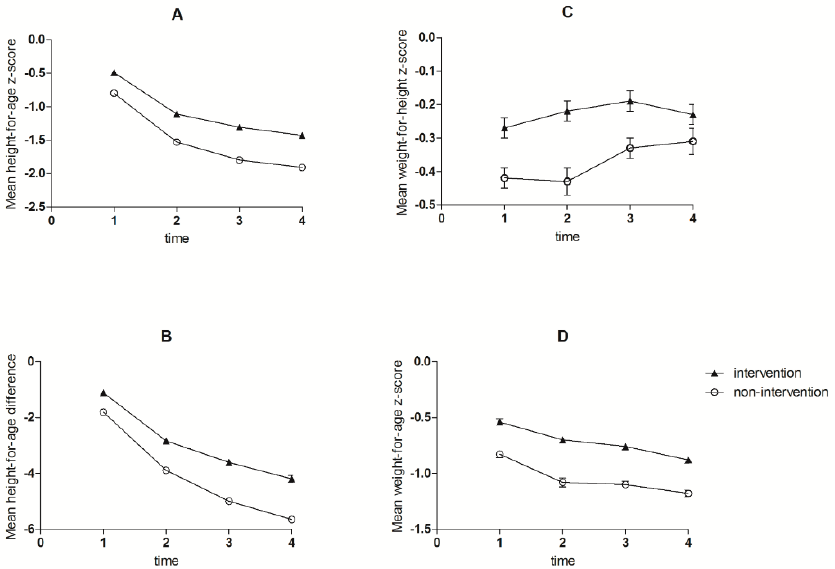
Figure 4. Mean height-for-age z-score ( A ); height-for-age difference ( B ); weight-for-height z-score ( C ) and weight-for-age z = score ( D ) of intervention during the study period.